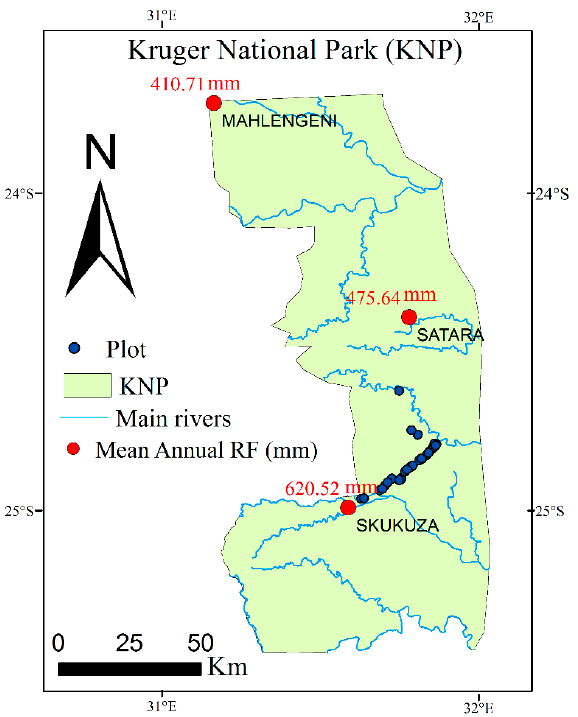
Figure 1. Location of the study area of Kruger National Park (KNP) (Southern part) in South Africa and its main river courses, indicating the locations of the sample plots of the field data collection in 2015. Blue circles indicate the field plot locations. The red points indicate the mean annual rainfall for the year 2002 to 2015 (14 years) of three stations in KNP.